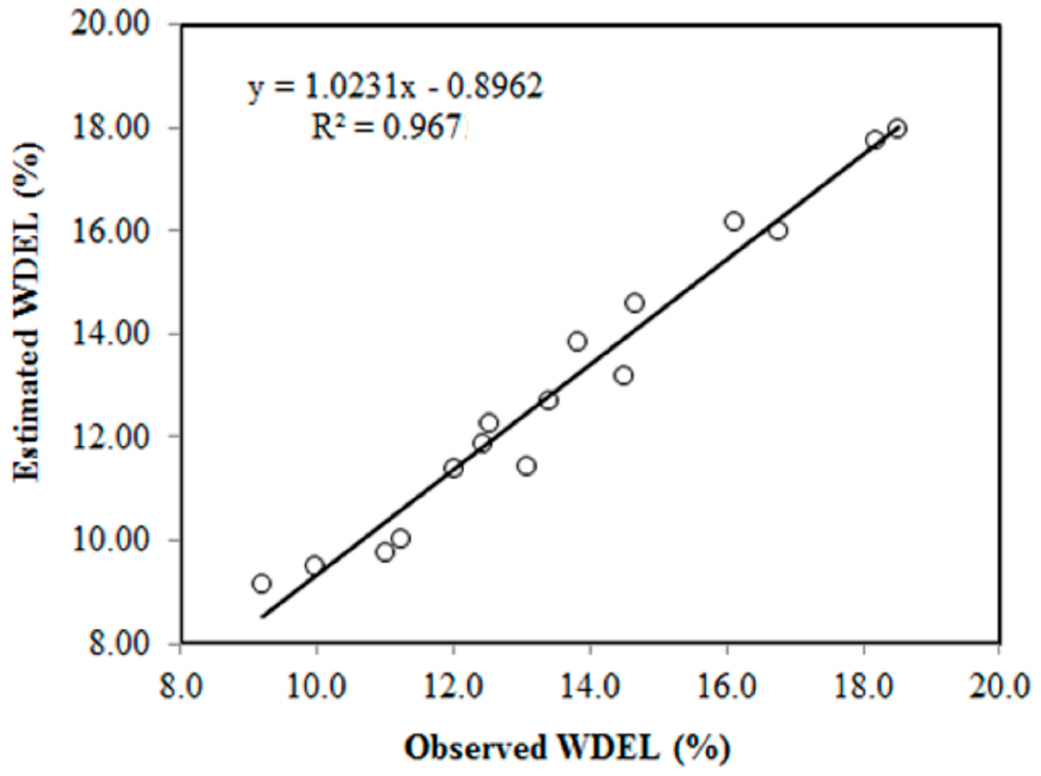
Table 4. Error statistics regarding WDEL estimation by the REPTree and ANN models using testing data set.